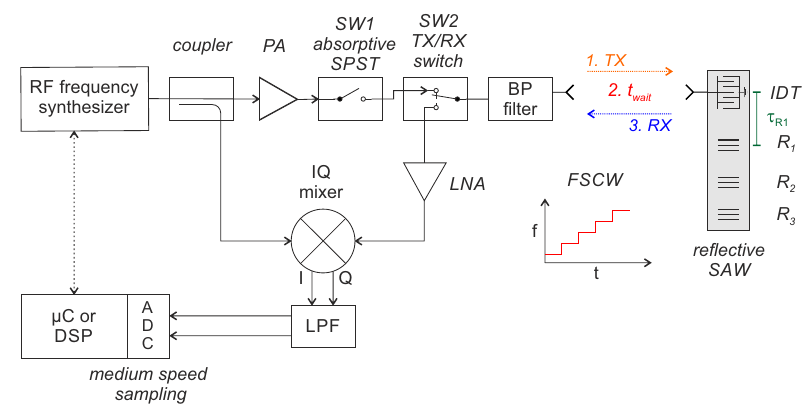
Figure 6. Block diagram of a monostatic reader concept using switched frequency stepped continuous wave interrogation for reflective delay line